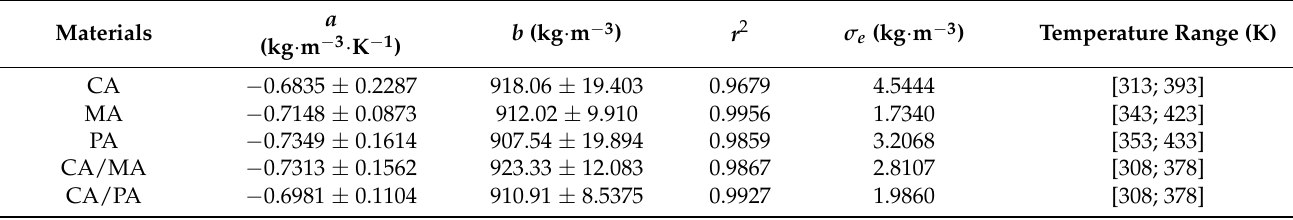
Table 5. Density in liquid state—Estimated values of the coefficients a and b in the equation ρ ( T ) = aT + b ( r 2 = regression coefficient; σ e = standard deviation of the error; T = temperature) at pressure p = 0.1 MPa *.